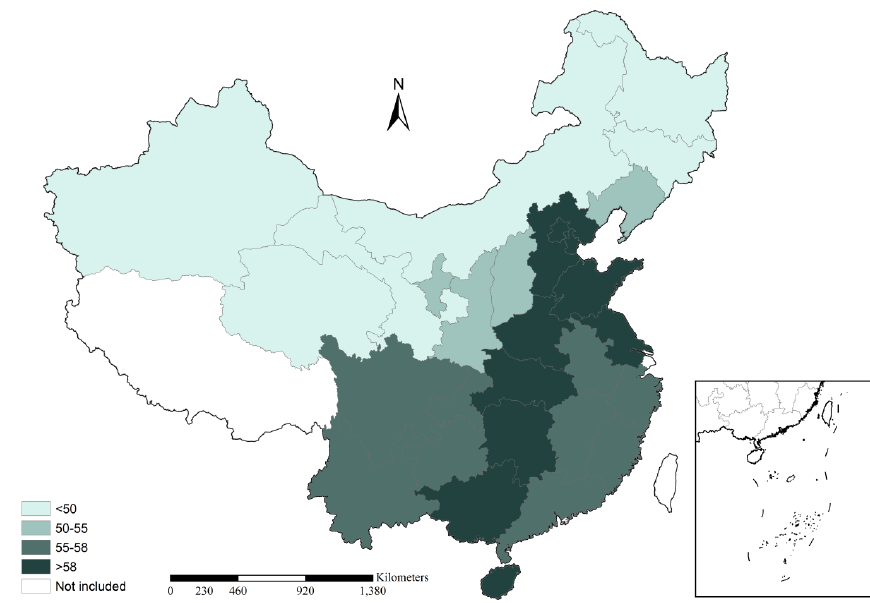
Figure 2. Regional energy poverty average scores in China. Note: It is a schematic map and does not imply definitive boundaries.